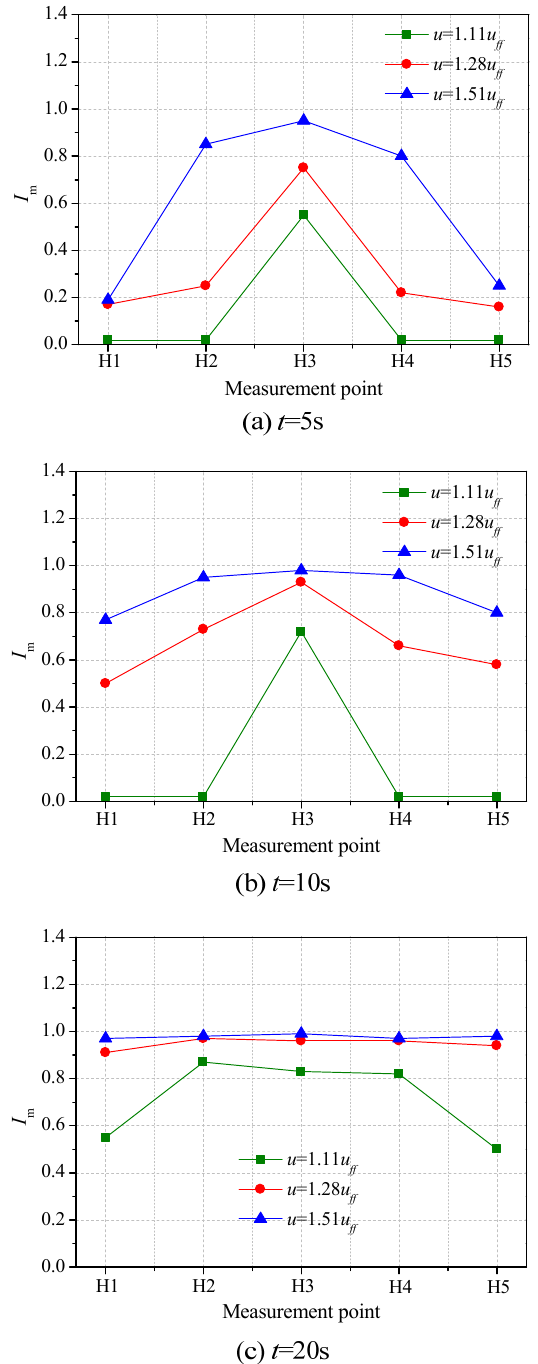
Figure 12. Variations of lateral distribution of mixing index with gas velocity after different time. Figure 13 shows the lateral distributions of I m at h = 0.75 H 0 when different static beds are used and the gas velocity is 1.28 u ff . At t = 5 s, a symmetric lateral distribution of I m with a peak at the middle is formed when the vertical segregated static bed is used. By contrast, asymmetric distributions of I m are formed when the other two types of static bed are used. When the lateral segregated static bed is used, lateral mixing at the left side is much better than that at the right side. Because when the lateral segregated static bed is used, the flow resistance on the left (light particles) is lower than that on the right (dense particles), the gas flows through the bed mainly along the left wall which improves the